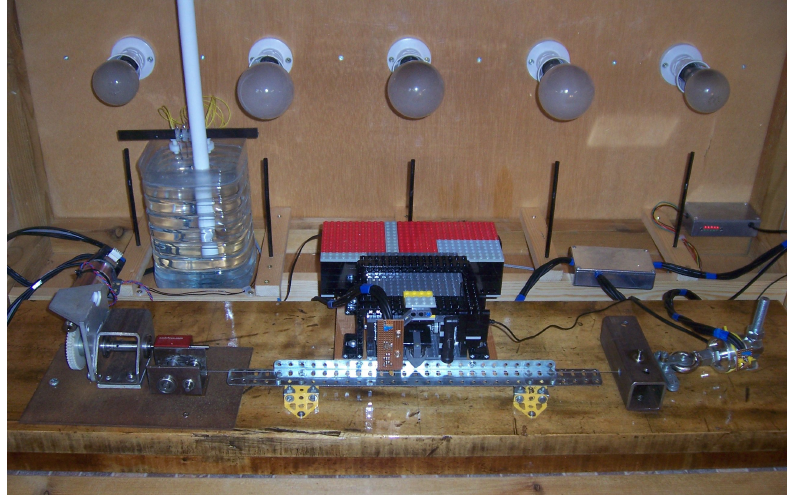
Figure 1. The test rig. The string winder and horizontal bridge pin assembly are mounted on the left of the baseboard, while the vertical bridge pin and load-cell are on the right. The motorised plucker, made from Lego, can be seen in the middle, with the microphone and the temperature and humidity sensor attached. The Meccano strips running behind and below the string provided a heat distribution bar to help even out the temperature along the string. The black plastic drinking straws below the light bulbs acted as light pipes, leading to sensors monitoring the light